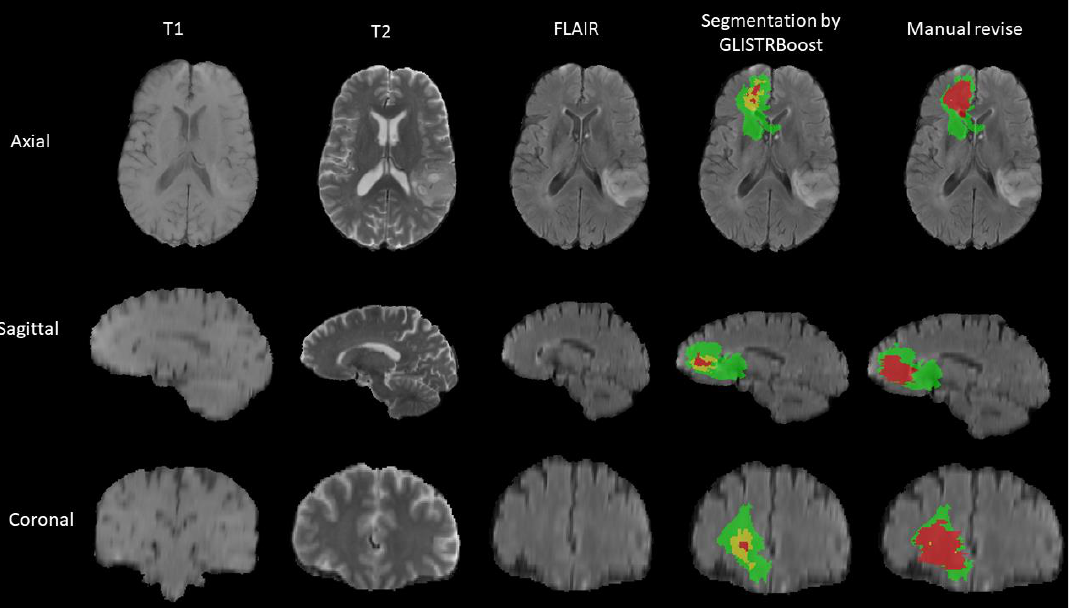
Figure 3. An example of MRI segmentation. The enhancing part of the tumor core (ET) in yellow, the non-enhancing part of the tumor core (NET) in red, and the peritumoral edema (ED) in